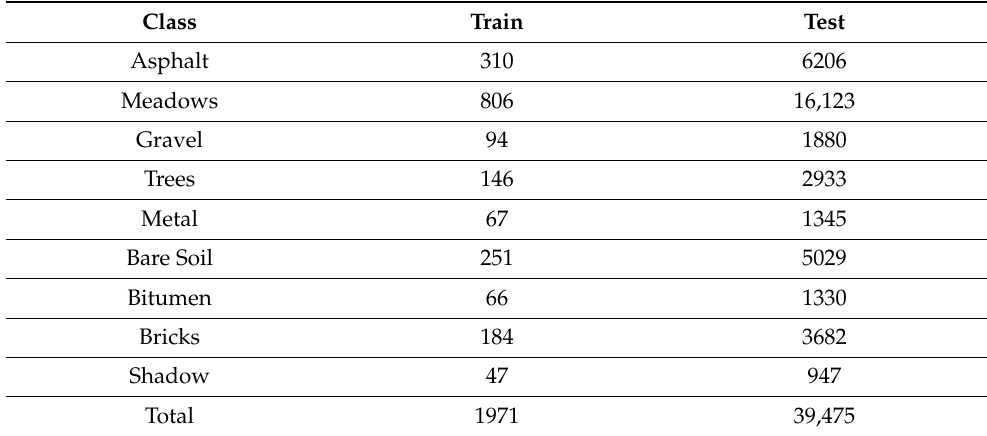
Table 2. Number of labeled samples and information classes (Pavia University).